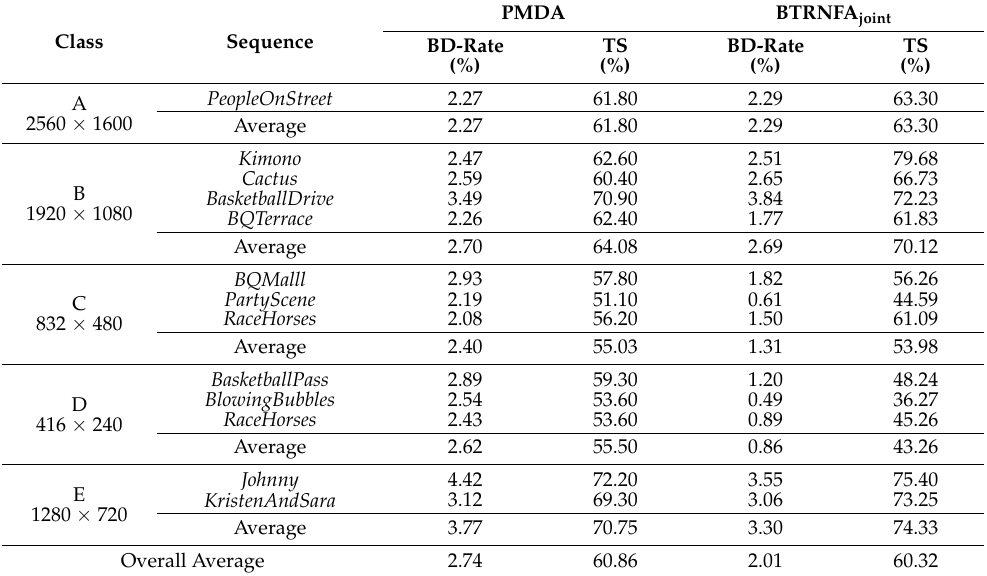
Table 8. Performance comparison between the proposed BTRNFA joint and PMDA under HM12.0; all intra